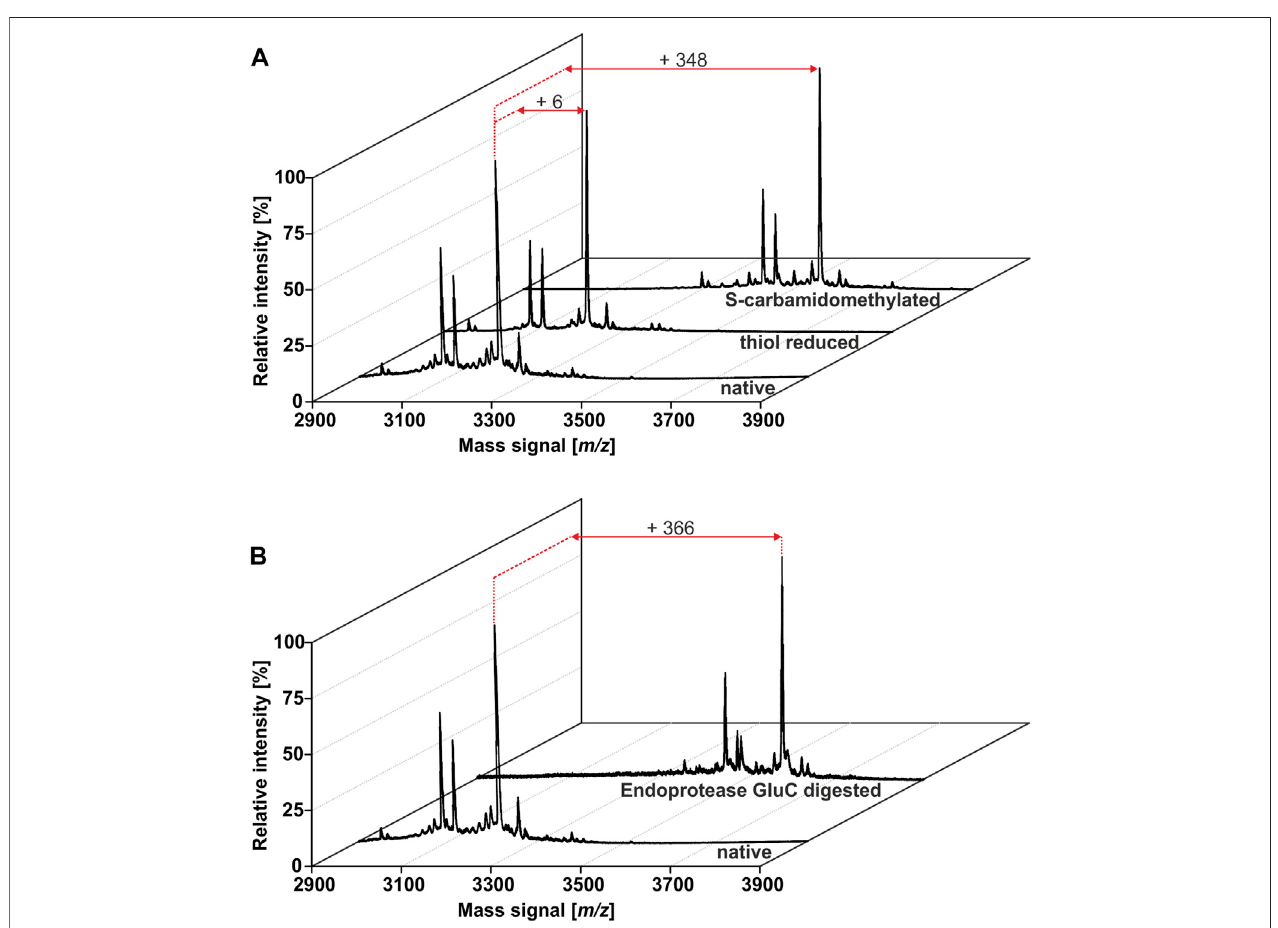
FIGURE 2 | Identi fi cation of cyclic cystine-rich peptides in A. cauli fl ora. A cystine identi fi cation work fl ow was applied to evaluate the number of cysteine moieties andthepresenceofasingleglutamicacidinthepeptides.MALDI-TOF-MSanalysisofnative,DTTandIAAtreatedsamplesenabledthemonitoringofcharacteristicmass shiftsof+1 Da and +58 Da per reduced and acetamidated cysteine, respectively. Thepeptideanalysisrevealed thepresence ofintotal 18 peptides with sixcysteines in A. cauli fl ora (A) . Furthermore, a site-speci fi c proteolytic cleavage using endopeptidase GluC obtained an additional mass shift of +18 Da (total of +366 Da) comparedtothe nativemassforall 18peptides.This resultindicates asingle conserved Gluin these peptides and due totheabsenceofother proteolytic fragments the experiment pinpoint on peptides with a cyclic backbone, e.g. cyclotides (B) .